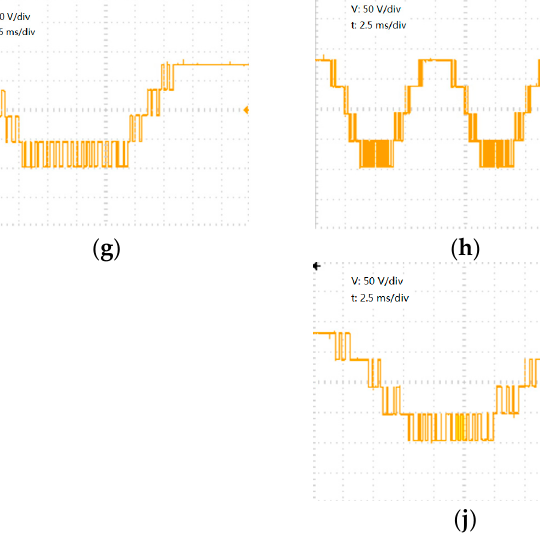
Figure 19. Waveforms of the 7-level inverter, ( a ) phase voltage A with m = 0.981; ( b ) line-to-line voltage AB with m = 0.981; ( c ) phase voltage A with m = 0.922; ( d ) line-to-line voltage AB with m = 0.922; ( e ) phase voltage A with m = 0.75; ( f ) details of the waveform in ( f ); ( g ) phase voltage A with m = 0.665; ( h ) phase voltage A with m = 0.665; ( i ) line-to-line voltage AB with m = 0.665; ( j ) details of the waveform in ( j ).